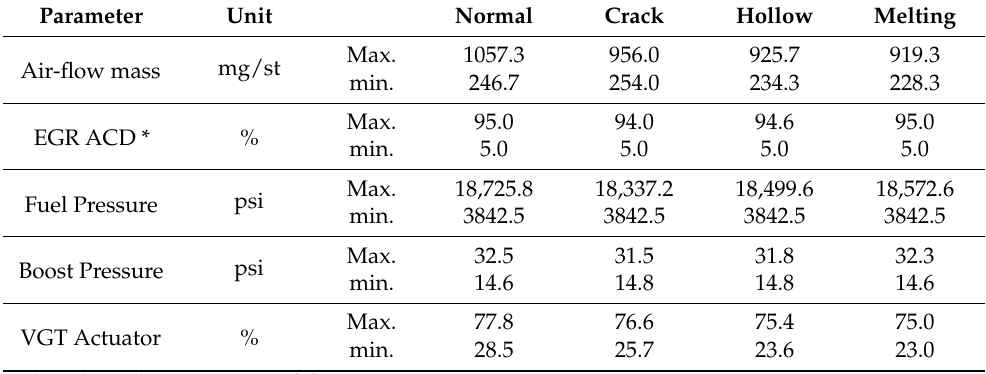
Table 6. OBD data with GDS device for KD-147 driving test.